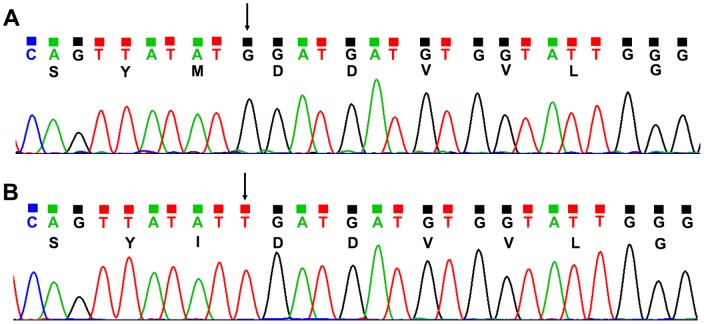
Typical chromatograms of the cloning sequencing of HBV rtM204 and rtM204I.(A) Chromatograms of rtM204 (wild-type). The bases in 204 site were ATG, indicated by the arrow. (B) Chromatograms of rtM204I (mutant). The bases in 204 site were ATT, indicated by the arrow.